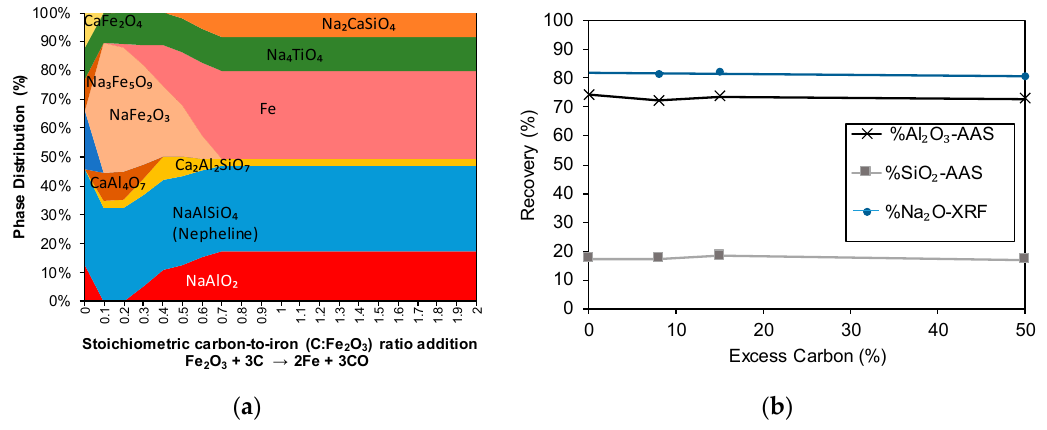
Figure 10. ( a ) Thermodynamic predictions of sinter phase formation and ( b ) results of experimental recovery of Al 2 O 3 , SiO 2 , and Na 2 O at the range of excesses of stoichiometric carbon additions (based on Carbon:Fe 2 O 3 ratio from bauxite residue) with 50% excess soda, 900 °C for 2 h.